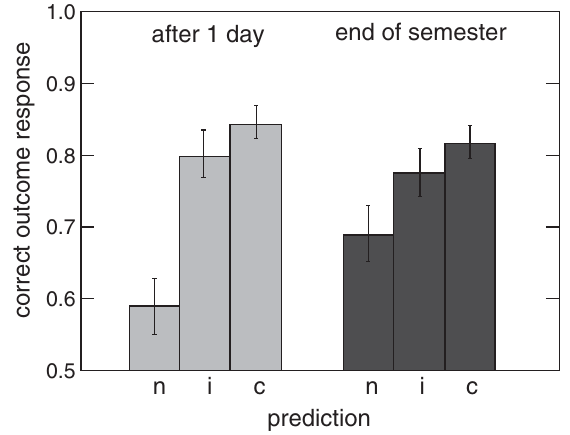
FIG. 1. Average percentage of correct response to the outcome question asked one day after the demonstration (light gray) and at the end of the semester (dark gray), for students who made no prediction (n) or predicted the demonstration correctly (c) or incorrectly